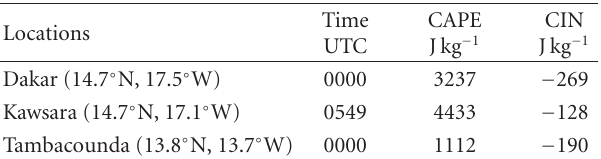
Table 1: Depiction of the CAPE and CIN for Dakar, Kawsara, and Tambacounda, Senegal, prior to the SL propagating into the vicinity of these